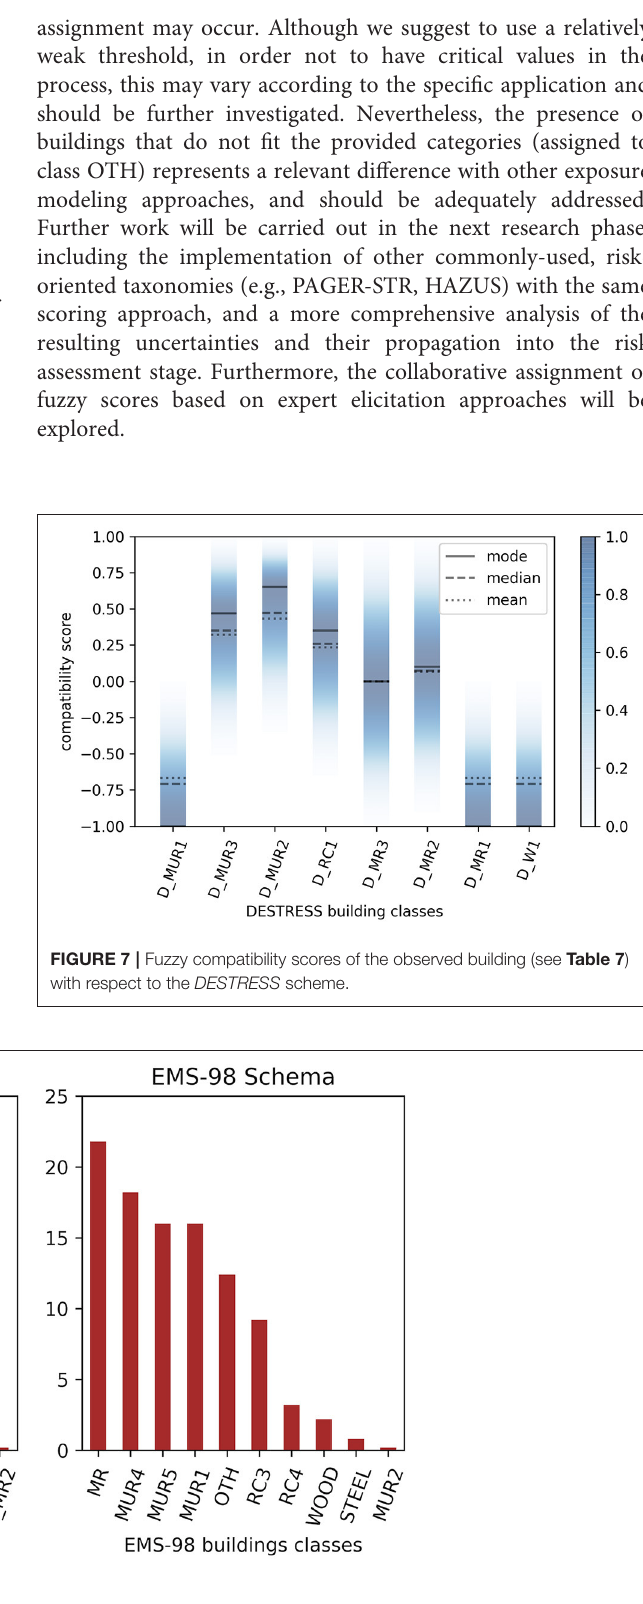
FIGURE 8 | Resulting exposure models using respectively the DESTRESS (left) and EMS-98 (right) class definition schema.